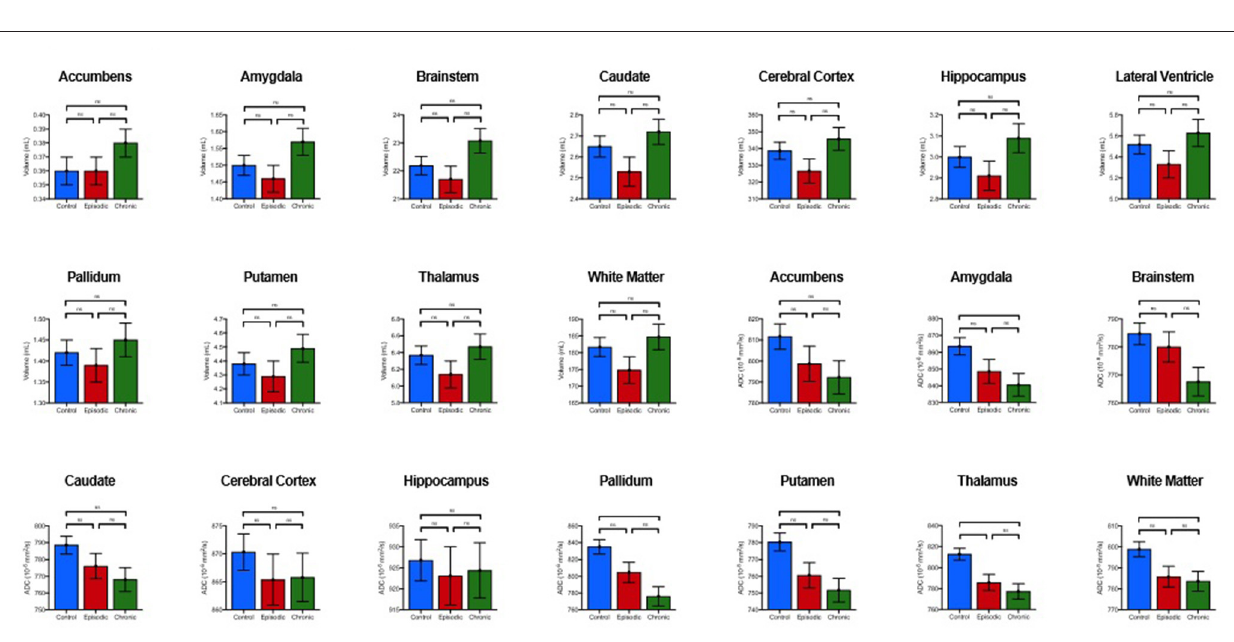
FIGURE 3 | Comparison of estimated marginal means and standard en-or means of volume and diffusion amongst chronic MTH, episodic MTH and controls. P -values and significance generated from post-hoc pair-wise analysis as denoted as follows: ns, * p < 0.05, ** p < 0.01, *** p < 0.001 (Bonferroni-corrected). Diffusion abnormalities of the limbic and pain sensitization brainstem, and cerebral white matter) were observed in structures (thalamus, caudate, putamen, pallidum, amygdala, individuals with MH. These structures have been